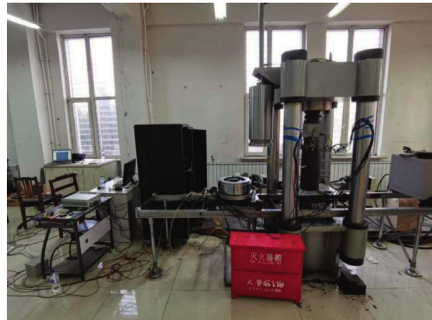
Figure 2: Physical map of the test system.